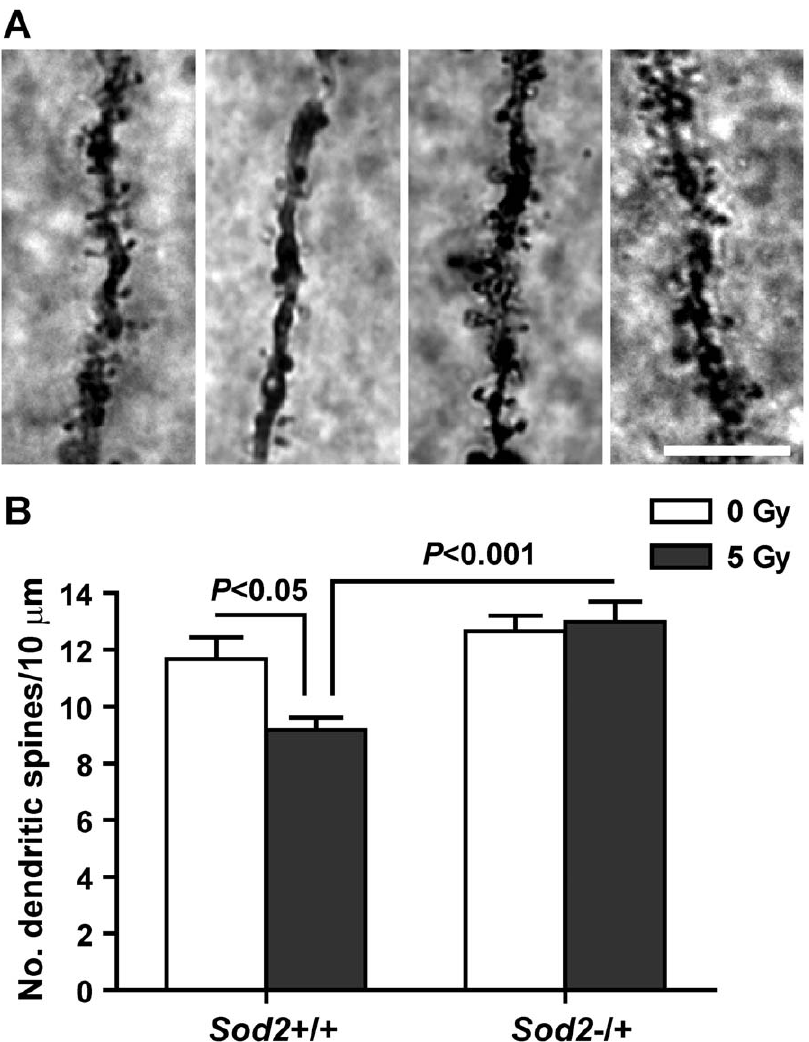
Figure 4. Dendritic spine density following behavioral studies. The number of dendritic spines was analyzed in secondary and tertiary dendrites of granule cells in the dentate gyrus after behavioral studies. Upper panel, representative photos from (left to right) Sod2 + / + /0 Gy, Sod2 + / + / 5 Gy, Sod2 2 / + /0 Gy, and Sod2 2 / + /5 Gy mice. Lower panel, average spine densities. Sample size: n=4, 6, 5, and 4 for Sod2 + / + /0 Gy, Sod2 + / + /5 Gy, Sod2 2 / + /0 Gy, and Sod2 2 / + /5 Gy, respectively. Only genotype ( F (1,15) =15.59, p=0.0013) contributed significantly to the data variations, and there was a significant interaction between genotype and treatment ( F (1,15) =5.46, p=0.0337). P values indicate Bonferroni post test results. Data are presented as mean 6 SEM. Scale bar=10 m